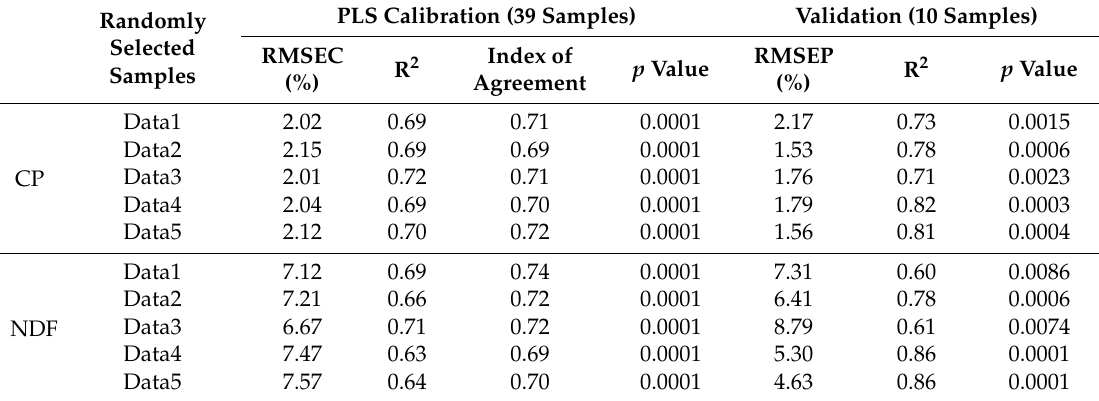
Table 4. Statistical parameters obtained for different randomly selected data sets, using the laboratory and field